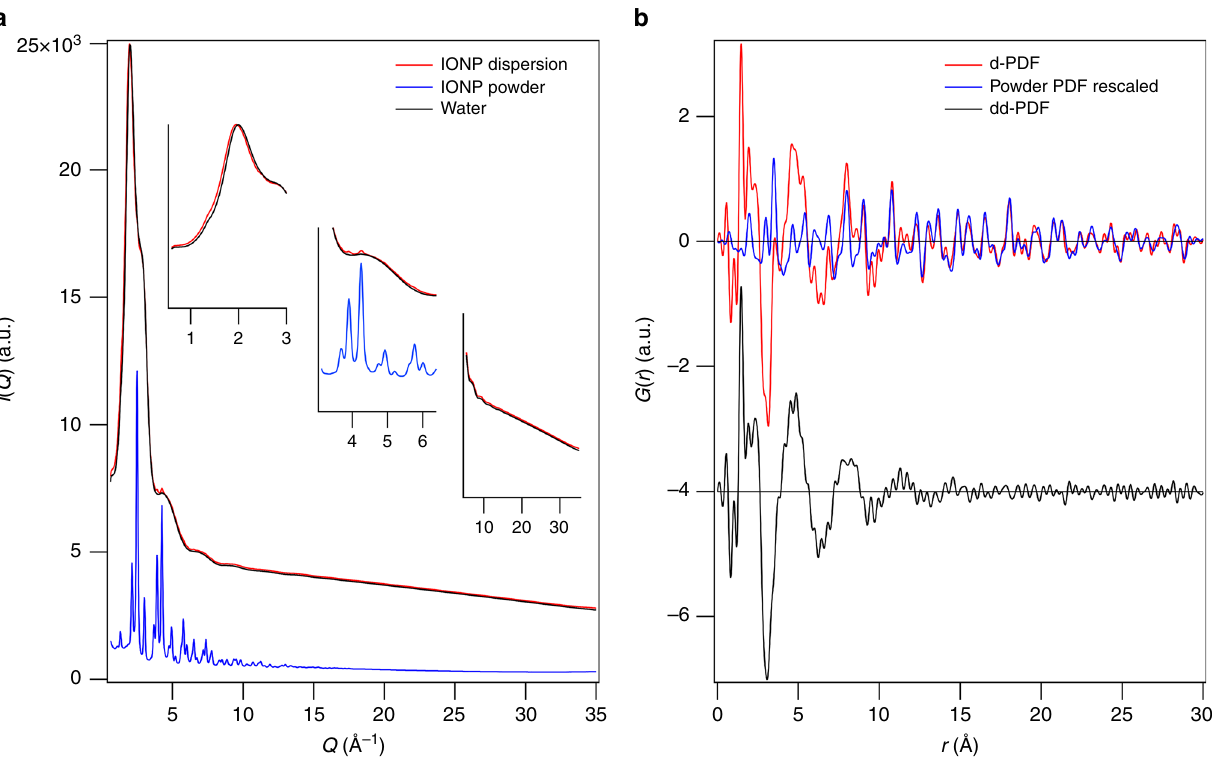
Fig. 1 Derivation of the hydration shell from experimental X-ray scattering data. a Integrated diffraction data I ( Q ) for the arginine-capped iron oxide nanoparticle (IONP) dispersion (red), the water background (black) and the IONP powder (blue). b The arginine-capped powder pair distribution function (PDF) ( G ( r ), blue) is scaled to the difference PDF (d-PDF) (red) in the range of 15 – 30 Å as only IONP peaks are present there. The hydration shell (black, in offset) contains the structural information of the molecular arrangement of the water molecules around the Figure 1b clearly features two regimes in the dd-PDF: sharp peaks below 3 Å and a broad oscillation above 3 Å (the small high-frequency ripples on this oscillation appear due to noise).